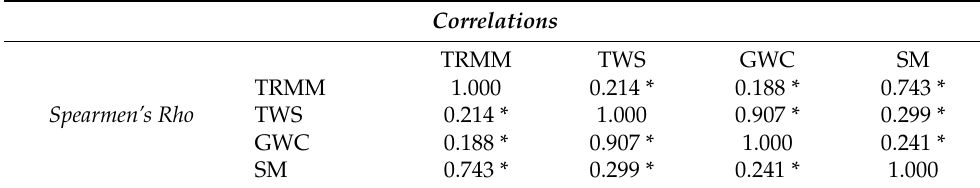
Table 2. Correlations between TRMM precipitation, TWS, and